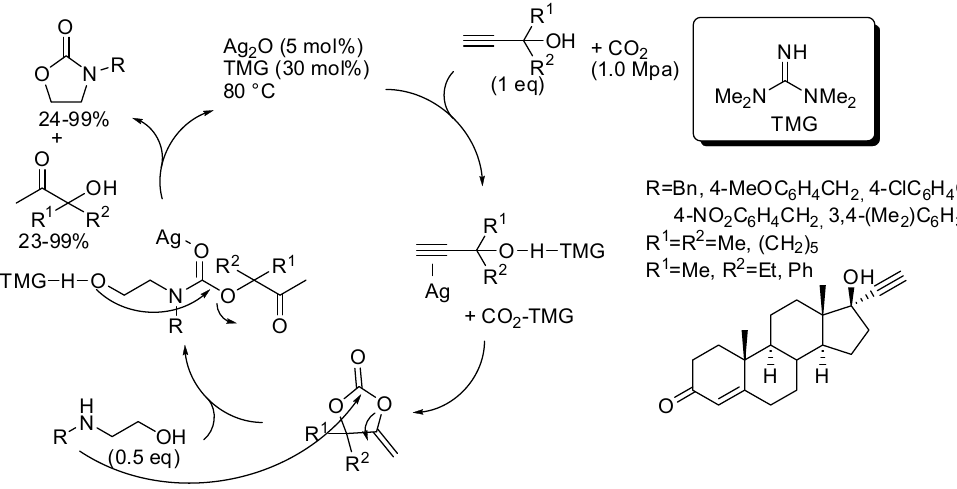
Scheme 22. Cascade reaction of propargyl alcohols, carbon dioxide, and